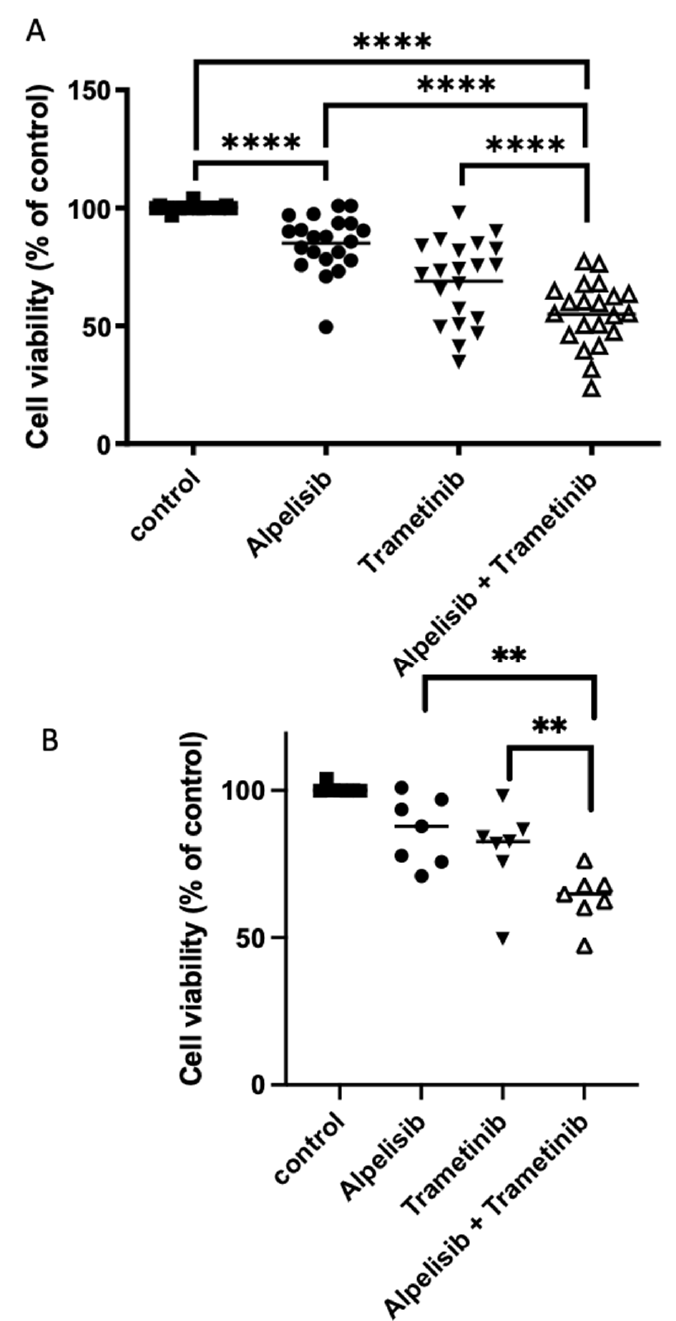
Figure 7. Combined treatment of alpelisib and trametinib in meningioma. ( A ): Inhibitory effect on cell viability of 10 − 6 M alpelisib, 10 − 7 M trametinib or combined treatment of both drugs on 21 meningiomas, including 14 WHO grade 1, 6 grade 2 and 1 grade 3 primary tumor cells. For each tumor, results are expressed as the percentage of cell viability relative to DMSO (dimethylsulfoxide)-treated control cells (“control”). ( B ): the same on 7 WHO grade 2 and 3 tumors. Black line: mean reduction of cell viability for the tumors. **** p < 0.001; ** p < 0.01.